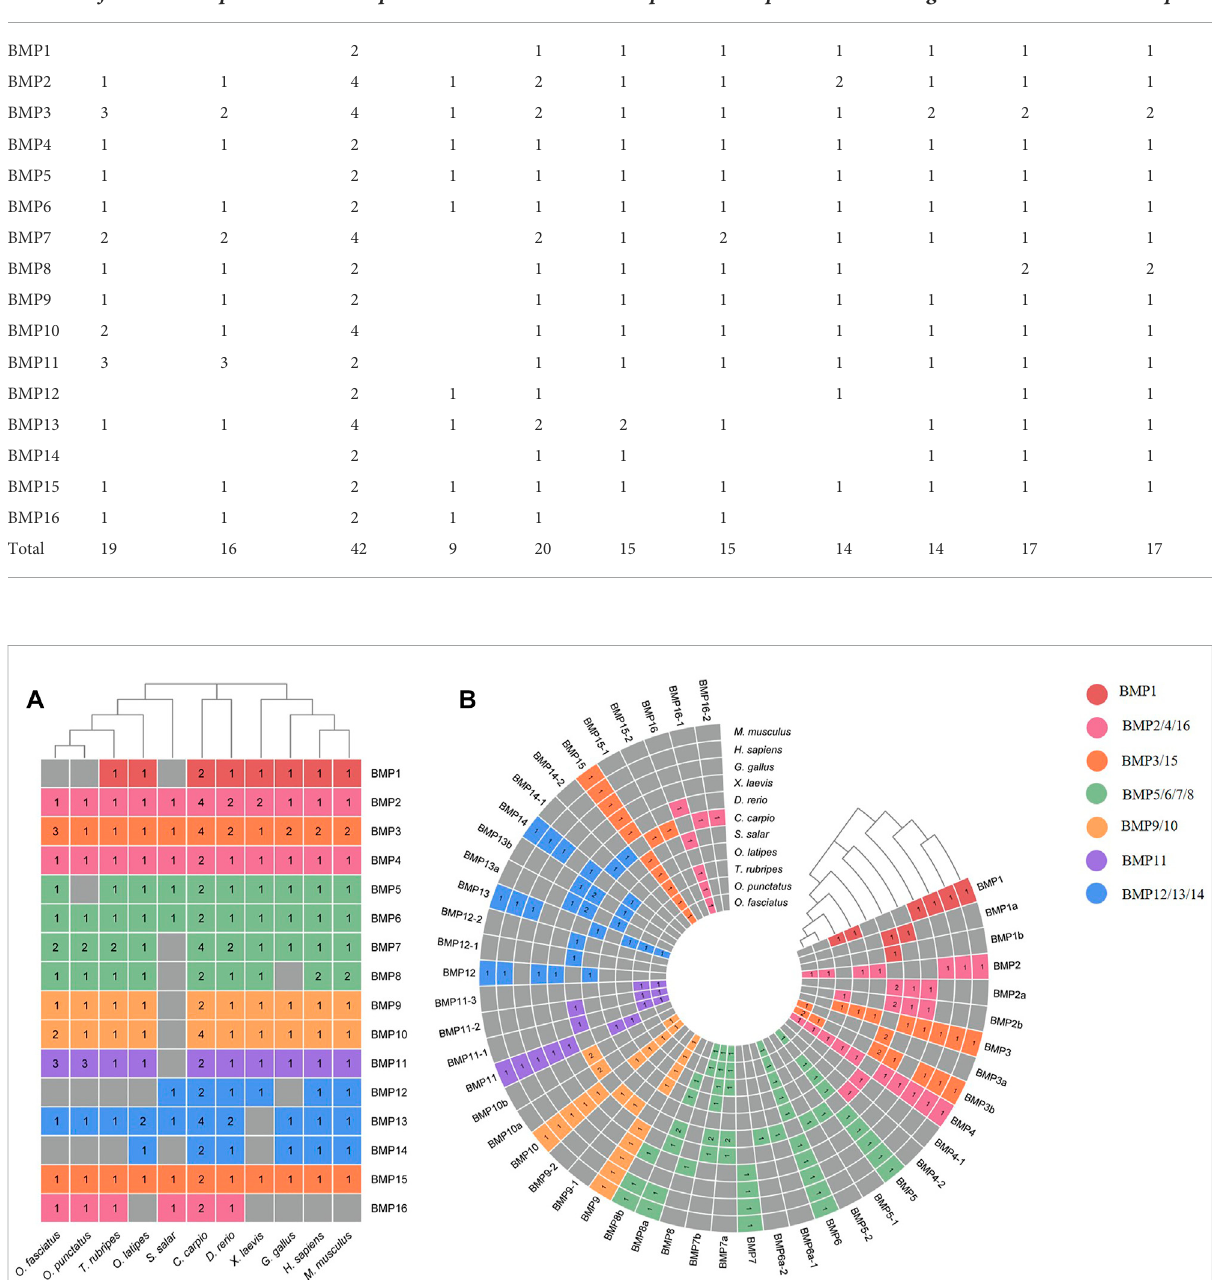
beak-like teeth, while BMP11-2 and BMP11-3 were highly expressed in the muscle and heart. Furthermore, there was signi fi cant downregulation in the liver for BMP11-2.